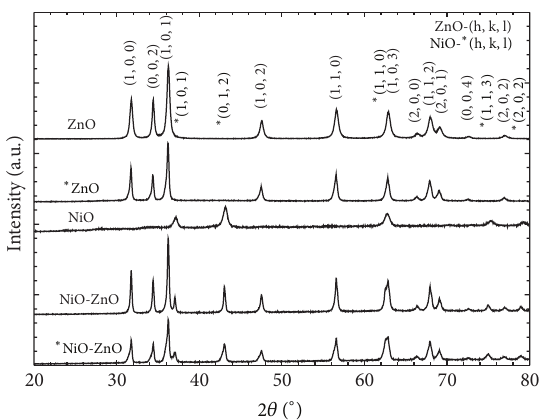
Figure 2: XRD pattern of the ZnO nanowhiskers, NiO nanoparti- cles, and NiO-decorated ZnO nanocomposites before and ( ∗ ) after photocatalytic test on the photodecomposition of MB.